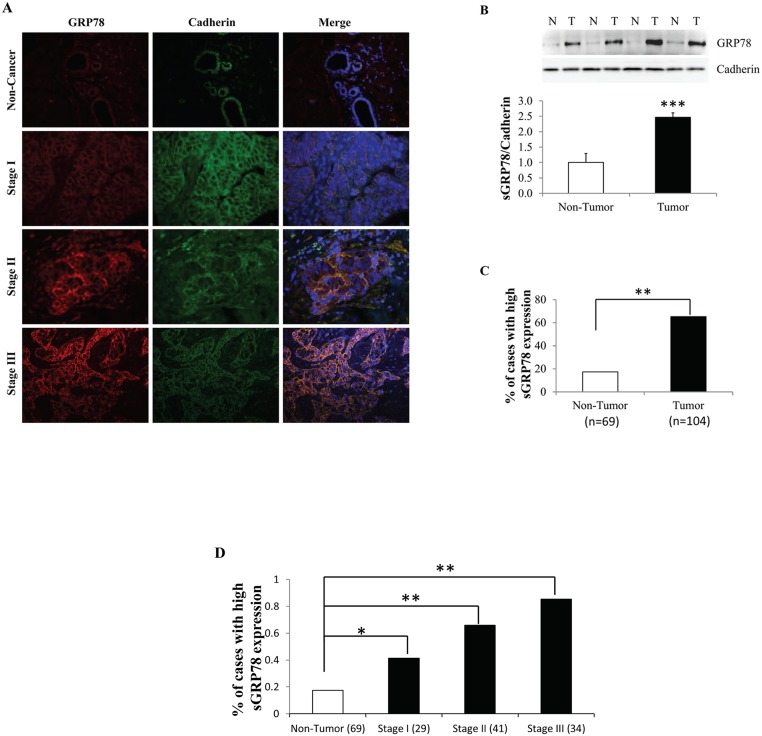
Association of sGRP78 expression with breast tumor progression.(A) Representative immunofluorescence staining of cell surface GRP78 (sGRP78) protein in sGRP78 positive human breast carcinomas. (B) Western blotting of sGRP78 protein in breast tumor and non-tumor tissues. The expression level of sGRP78 was normalized to E-cadherin and is represented in the bottom panel. (C) The percentage of sGRP78 highly stained cases in 104 tumor tissues and 69 non-tumor tissues detected by immunofluorescence analysis. (D) Distribution of sGRP78 highly stained cases with tumor characteristics. *p<0.05, **p<0.01, ***p<0.001 vs the non-tumor group. N: non-tumor tissue; T: tumor tissue.